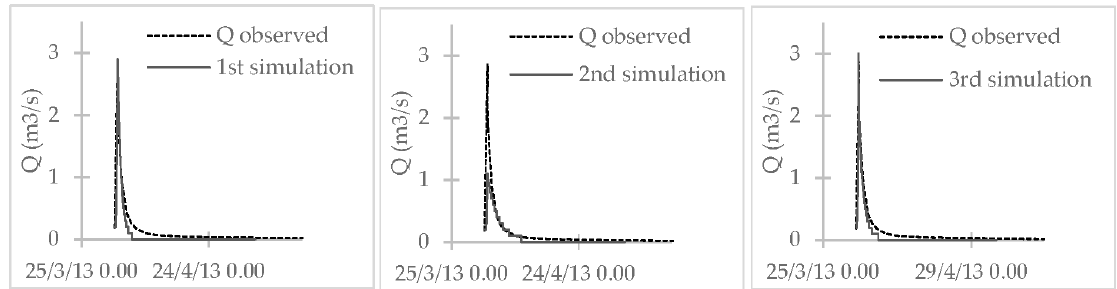
Figure 8. Comparison between the observed and simulated hydrographs for the first, second, and third simulations.